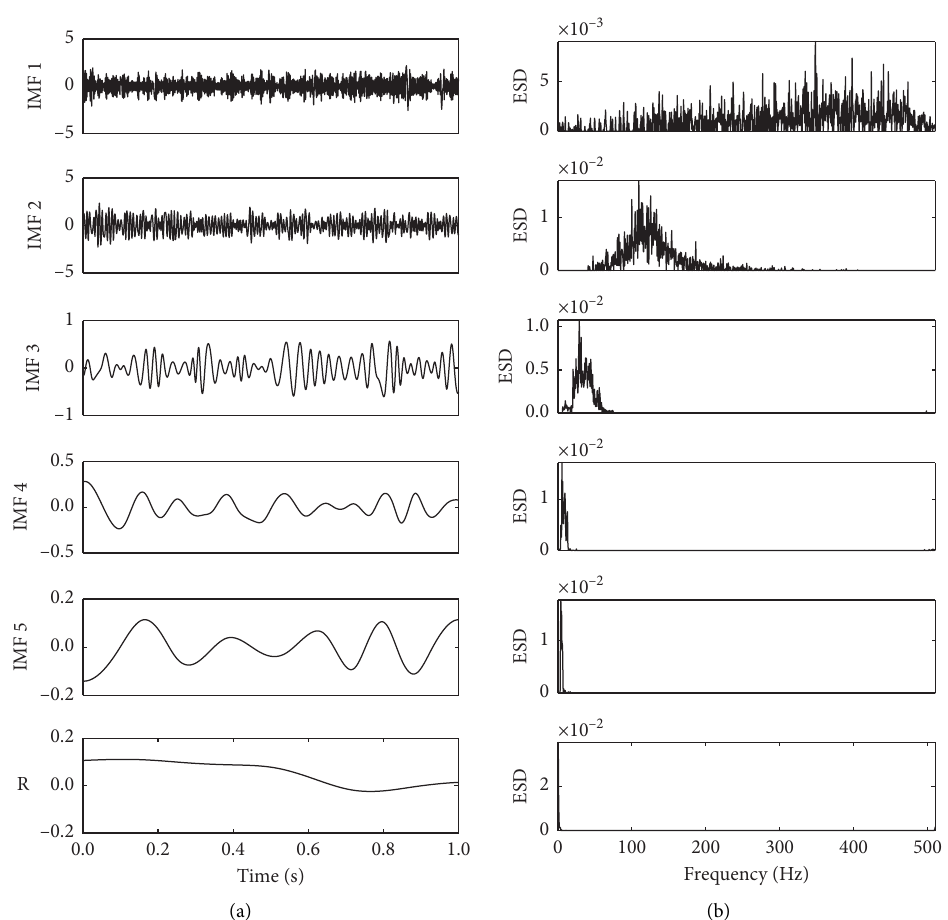
Figure 3: Results of EMD-HT time-frequency analysis. (a) Decomposition results of EMD. (b) IMF marginal